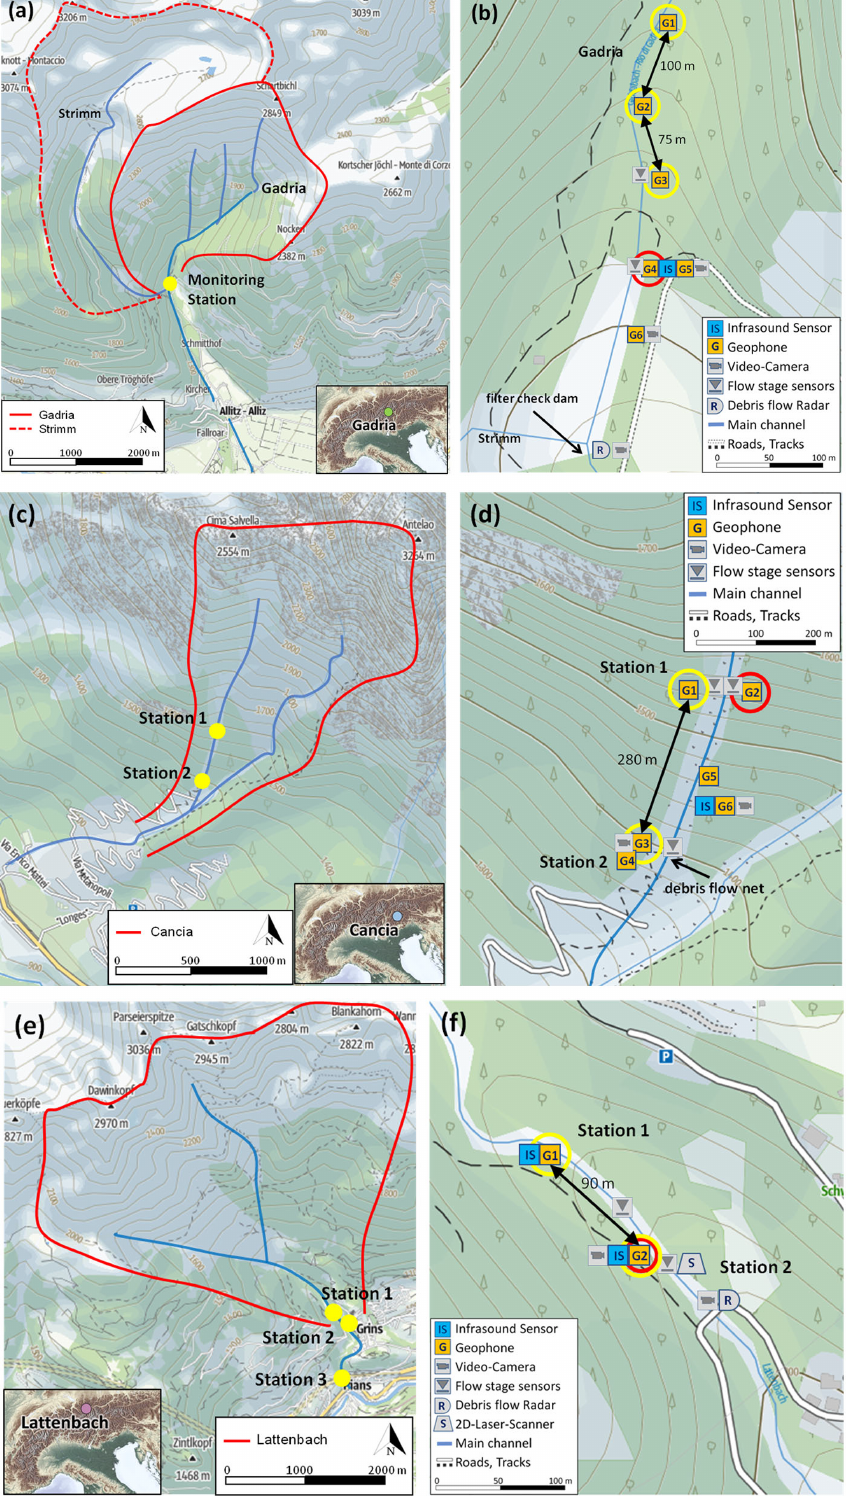
Figure 1. Overview of the Gadria site (a) , Cancia site (c) , and Lattenbach site (e) . (b) , (d) , (f) Closer view of the monitoring stations and sensor setup (based on © OpenStreetMap contributors 2022. Distributed under the Open Data Commons Open Database License (ODbL)